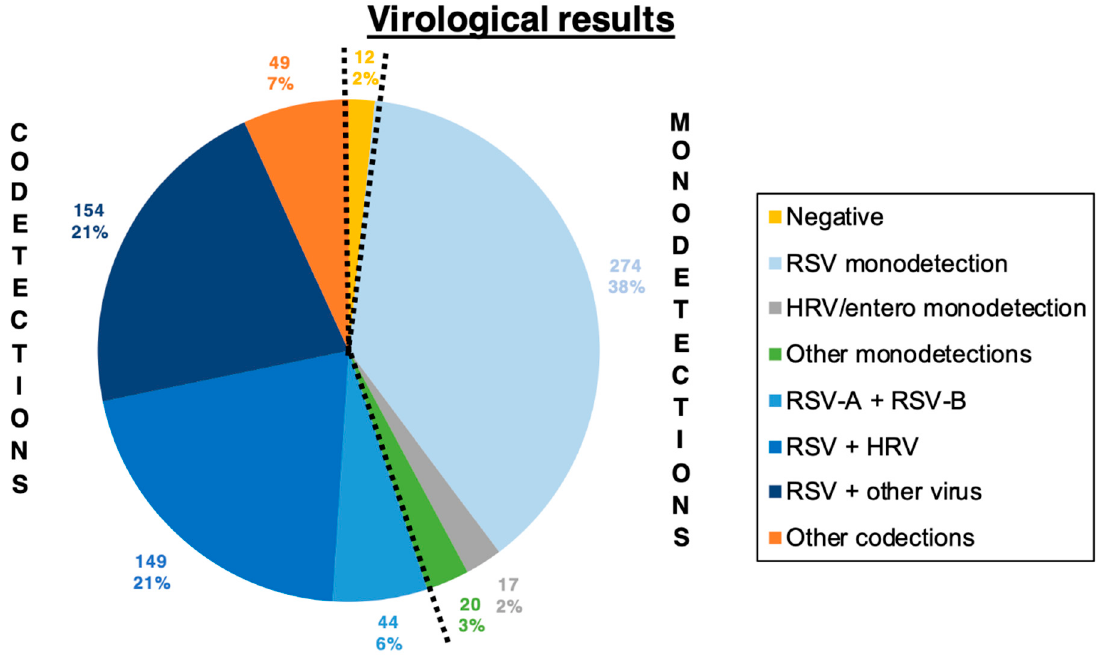
Figure 1. Virological results.